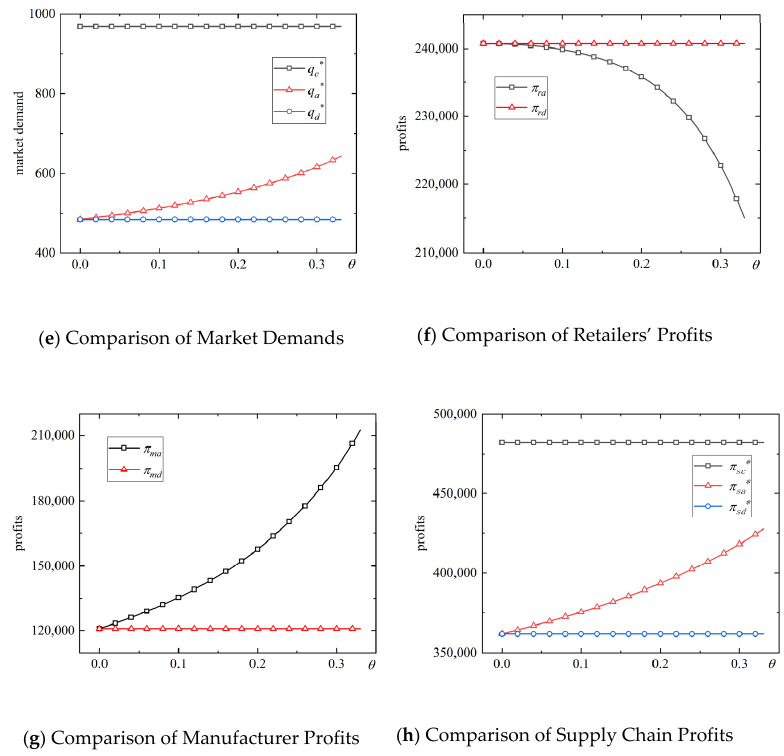
Figure 5. Comparison of Optimal Decisions among the Three Models.